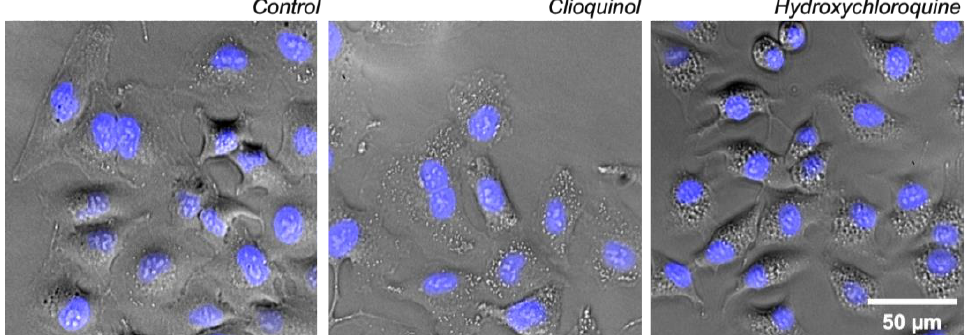
Figure 8. Cellular morphology of A549 control cell and cells treated for 24 h with 2.5 µM CQ or HCQ. Nuclei were counterstained with NucBlue Live to determine the number of nuclei and to assess gross cell morphology. Magnification ×20, scale bar 50 µm.